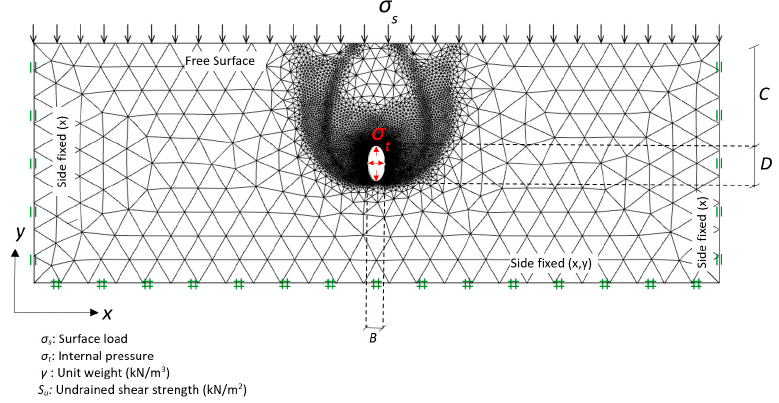
Figure 3. Problem definition and FELA mesh ( B/D =